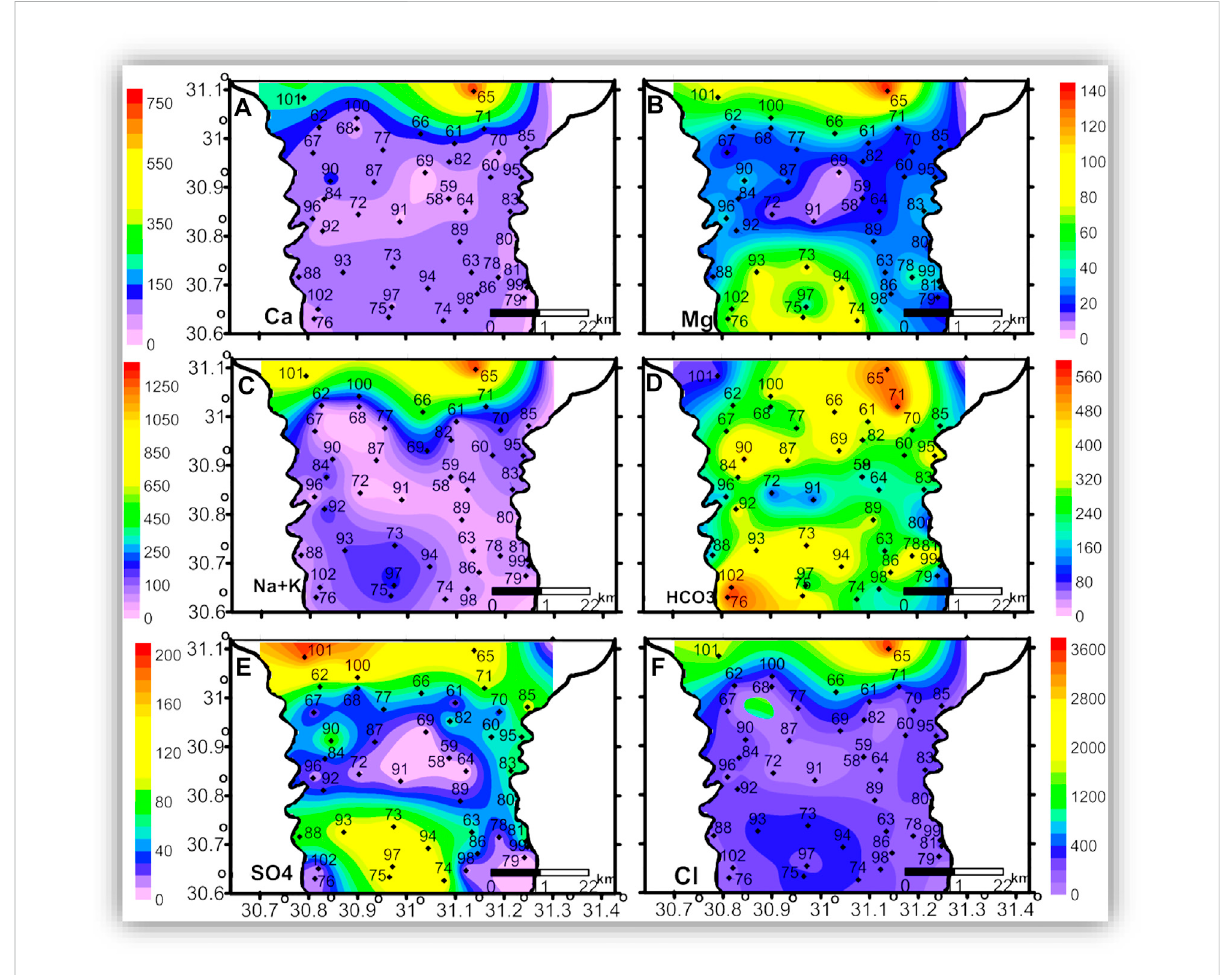
FIGURE 7 The spatial distribution maps of the major ion concentrations (mg/l) of the groundwater samples in the intermediate